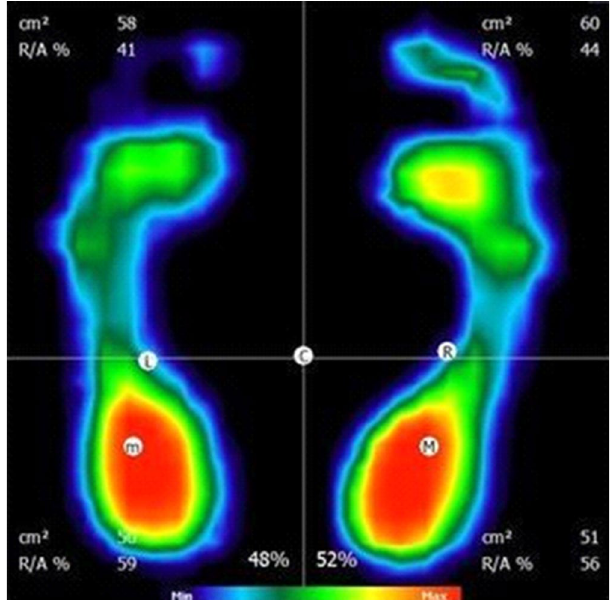
Figure 6. An example of a foot pressure test, as carried out on the FreeMed platform, in static conditions. (Source: Own